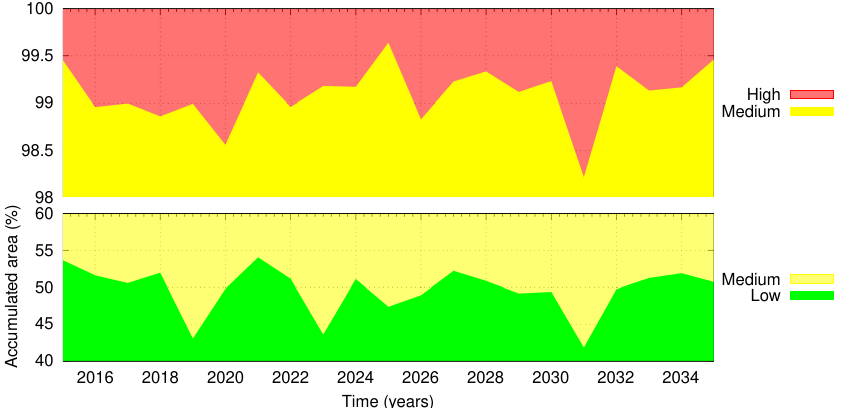
Figure 11. Cumulative area distribution occupied by the global vulnerability for the RCP6.0 (years 2015 to 2035).